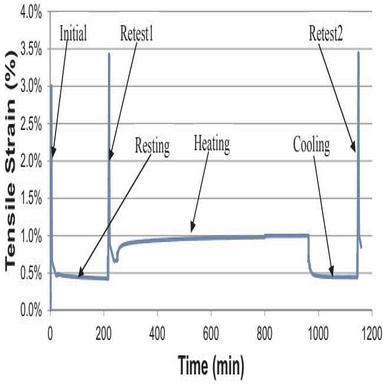
Behaviour of specimen with 10 wt% microcapsules over multiple testing cycles.